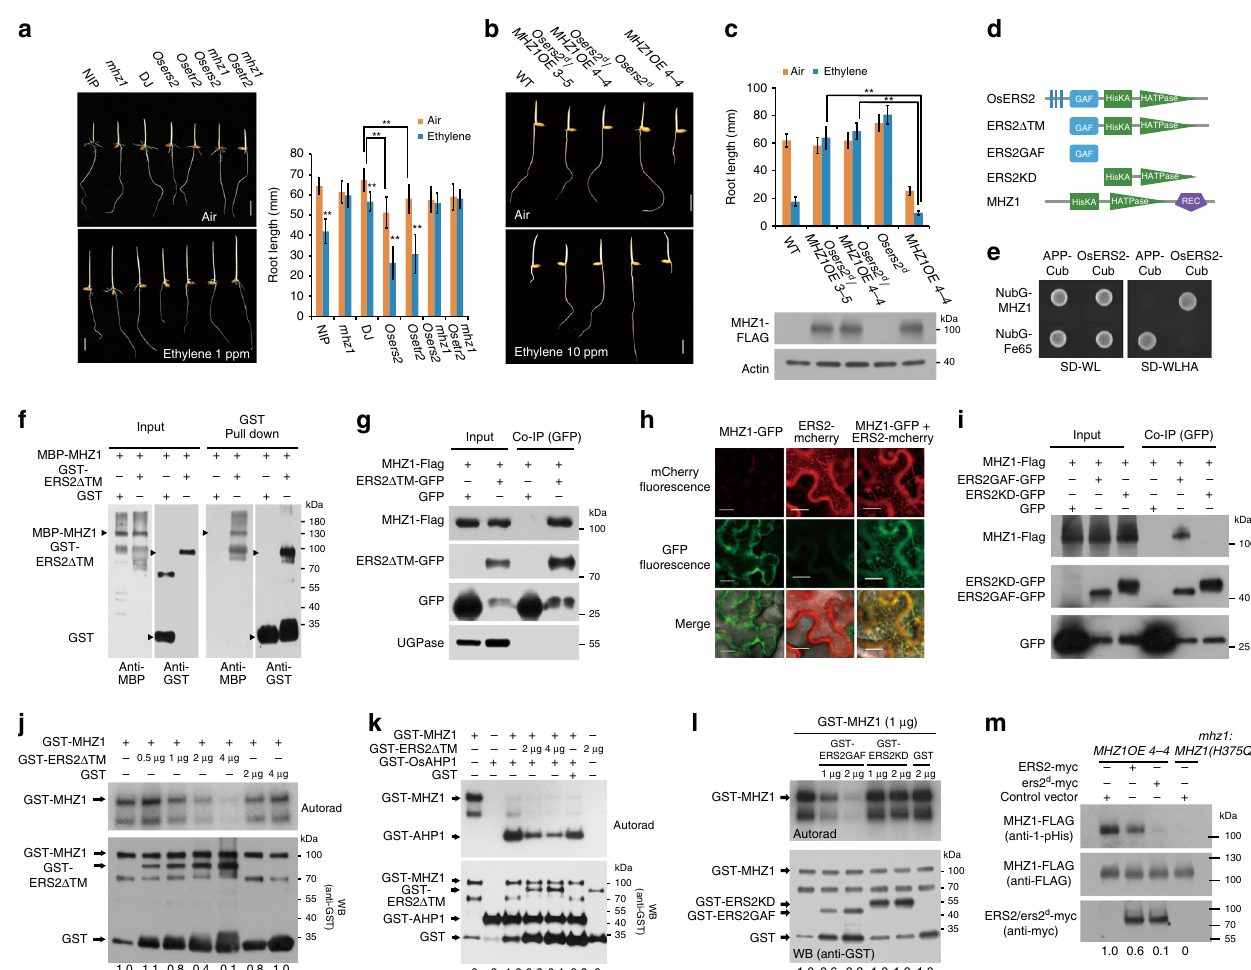
Fig. 4 MHZ1 physically interacts with and inhibited by ethylene receptors. a mhz1 suppressed the ethylene hypersensitivity of Osetr2 (Dongjin) and Osers2 (Dongjin) loss-of-function mutants. (Left) Seedlings were treated with air or 1 ppm ethylene. (Right) Data are means ± SD, n > 30. ** P < 0.01; Student ’ s t -test. DJ, Dongjin; Nip, Nipponbare. Bars indicate 10 mm. b Ethylene response of Osers2 d /MHZ1-OE lines. Etiolated seedlings were treated with air or 10 ppm ethylene. Bars indicate 10 mm. c Root length quanti fi cation of each line in b . Total proteins of each line were immunoblotted for MHZ1-FLAG with anti-FLAG antibody. Data are means ± SD, n > 30. ** P < 0.01; Student ’ s t -test. d Schematic structures of MHZ1 and OsERS2 and their truncated versions. e Split-ubiquitin Y2H assay for interaction of MHZ1 and OsERS2. Combination of pTSU2-APP and pNubG-Fe65 (provided in the kit) was used as a positive control. f Pull-down of MBP-MHZ1 with GST-OsERS2 Δ TM in E. coli . g Co-IP assays for interaction of MHZ1 and OsERS2. The constructs were cotransformed into rice protoplasts. Total proteins were immunoprecipitated with GFP-Trap and immunoblotted with anti-GFP, anti-FLAG, and anti- UGPase antibodies. h OsERS2 facilitates the ER membrane localization of MHZ1. MHZ1-GFP and OsERS2-mCherry proteins were transiently expressed in tobacco leaf epidermal cells. Bars indicate 20 μ m. i Co-IP assays for interaction domain mapping of MHZ1 and OsERS2. The constructs were cotransformed into rice protoplasts. Total proteins were immunoprecipitated with GFP-Trap and immunoblotted with anti-FLAG, anti-GFP antibodies. j OsERS2 inhibits MHZ1 kinase activity. GST was added as a control. Values at the bottom indicate relative phosphorylation levels of GST-MHZ1. k OsERS2 inhibited phosphate groups relayed to OsAHP1. Values at the bottom indicate relative phosphorylation levels of GST-AHP1. l GAF domain of OsERS2 inhibits MHZ1 kinase activity. GST was added as a control. Values at the bottom indicate relative phosphorylation levels of GST-MHZ1. m Histidine phosphorylation of MHZ1 is suppressed by OsERS2 and Osers2 d . Vectors carrying OsERS2-myc and Osers2 d -myc were transformed into protoplasts of MHZ1OE 4-4 . Total protein was immunoprecipitated with anti-FLAG af fi nity gel and immunoblotted with anti-FLAG or anti-1-p-His (Millipore, MABS1330) antibodies. Values at the bottom indicate relative phosphorylation levels of MHZ1. Protoplasts of ProMHZ1:MHZ1(H375Q) transgenic line transformed with the control vector were used as negative control. Source data are provided as a Source Data fi suggesting that MHZ1 interacts with OsERS2 in yeast cells leaf epidermal cells and fl uorescence was examined. When (Fig. 4e). GST pull-down assay and coimmunoprecipitation (Co- expressed separately, OsERS2-mCherry was mainly detected in a IP) assay in rice protoplasts further reveals that OsERS2 can reticular network-like structure, while MHZ1-GFP was mainly interact with MHZ1 both in vitro and in rice cells (Fig. 4f, g). detected in the cytoplasm. When expressed together, MHZ1-GFP Since MHZ1 lacked the transmembrane domain and is predicted was found to co-localize with OsERS2-mCherry, suggesting that to be a cytoplasmic protein, we examined whether its interaction OsERS2 facilitated the ER membrane localization of MHZ1 with OsERS2 could help it localize to the ER membrane through (Fig. 4h). In addition, protein fractionation assay shows that quite the membrane recruitment assay (MeRA) 50 . MHZ1-GFP and amounts of MHZ1 protein were detected in the membrane OsERS2-mCherry proteins were transiently expressed in tobacco fractions especially in the presence of gain-of-function Osers2 d ,